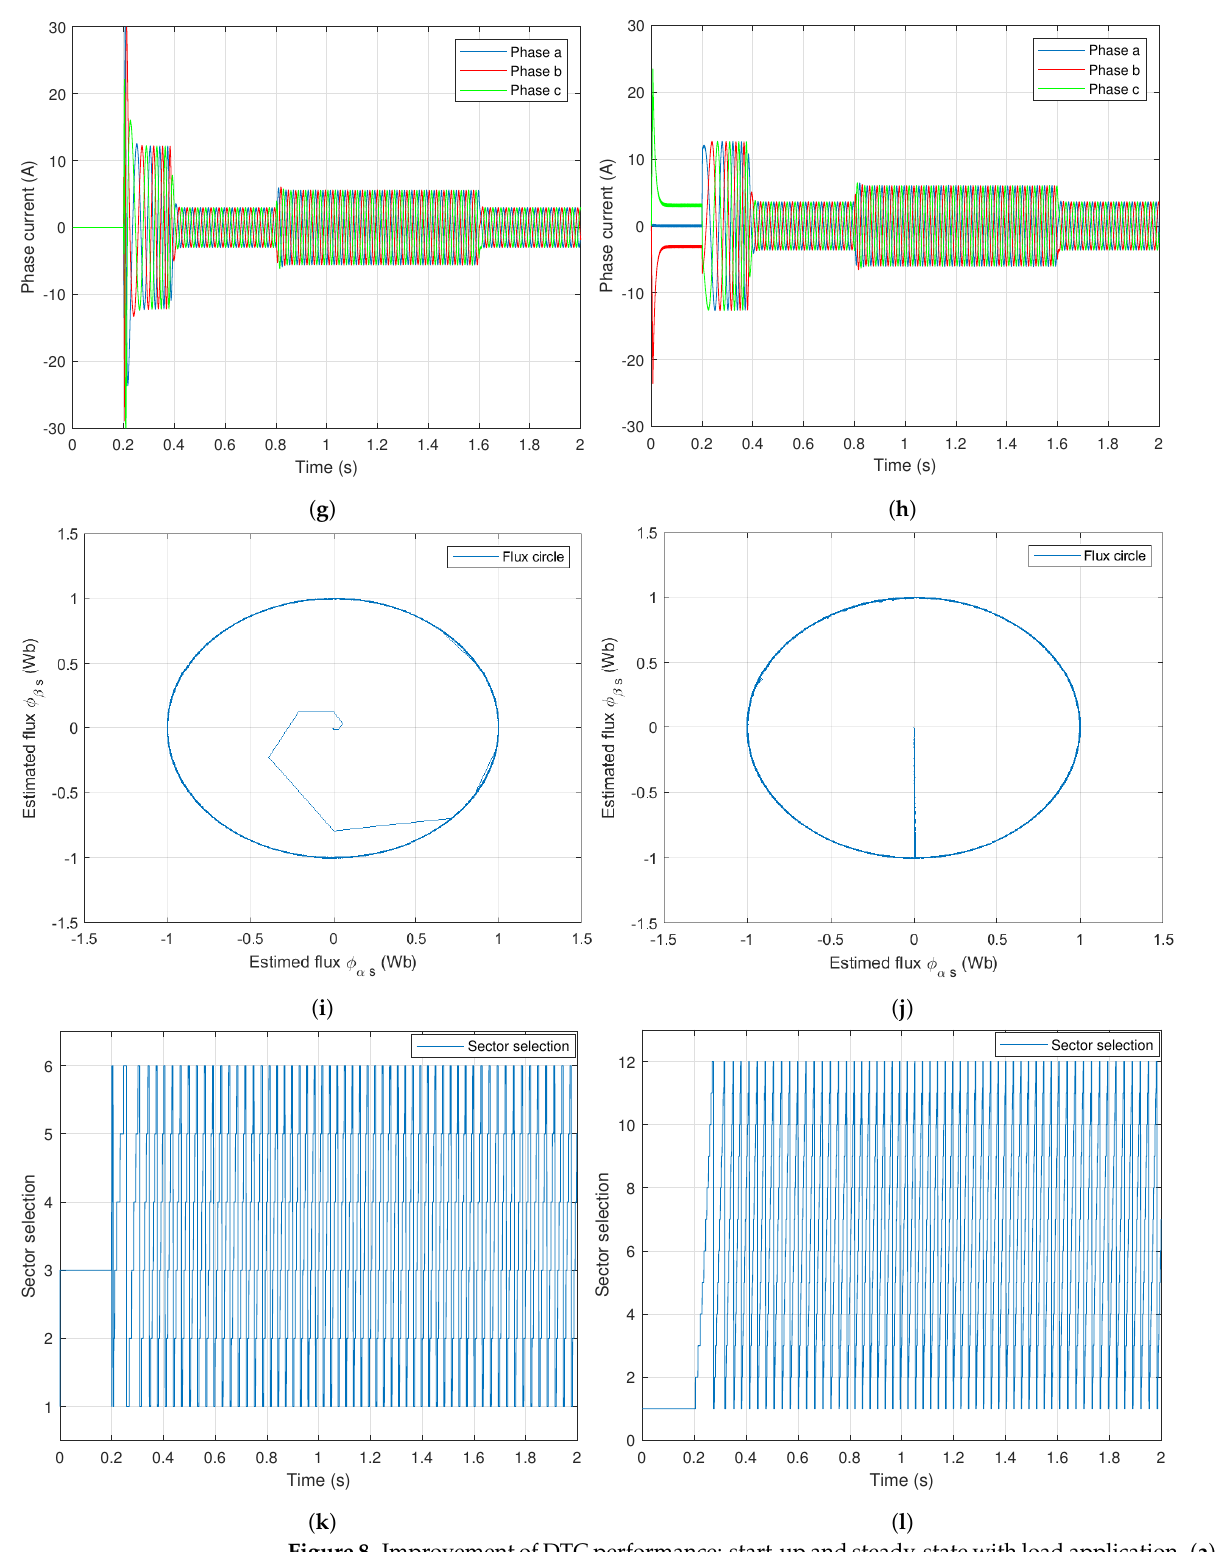
Figure 8. Improvement of DTC performance: start-up and steady-state with load application. ( a )